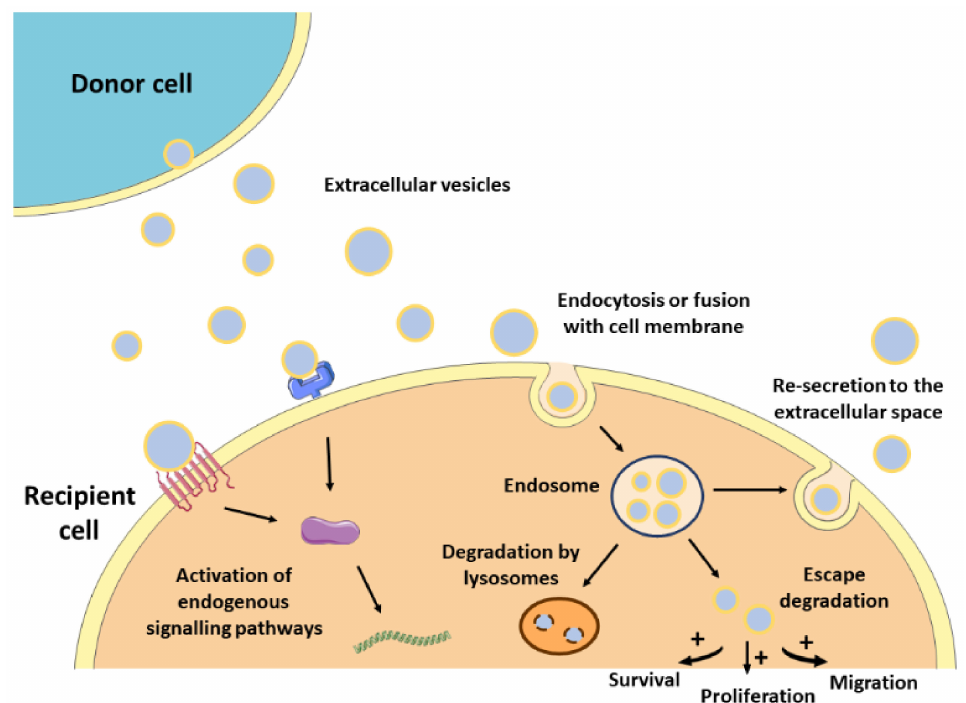
Figure 1. Mechanism of action of EVs. After released from donor cells, EVs may induce a response in recipient cells by different mechanisms. First, EVs may remain at the binding site on the cell membrane eliciting functional responses by activating downstream molecular pathways. Alternatively, EVs may be internalized by endocytosis or fusion with the cell membrane undergoing different intracellular fates. They can be targeted for degradation by lysosomes, they can escape degradation and modulate cell behavior, or they can be re-secreted to the extracellular